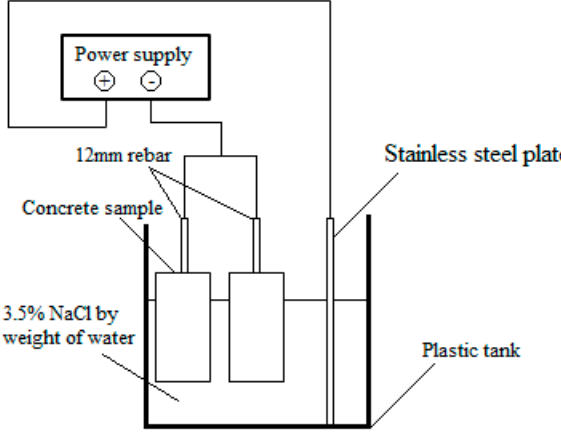
Figure 16. Schematic of the accelerated corrosion test setup.